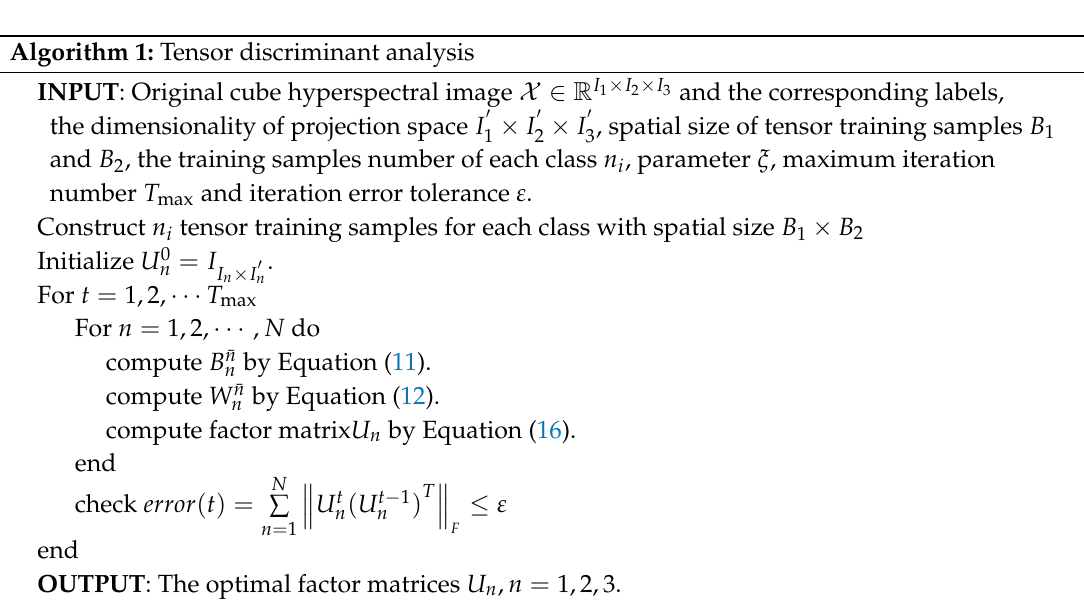
Algorithm 1: Tensor discriminant